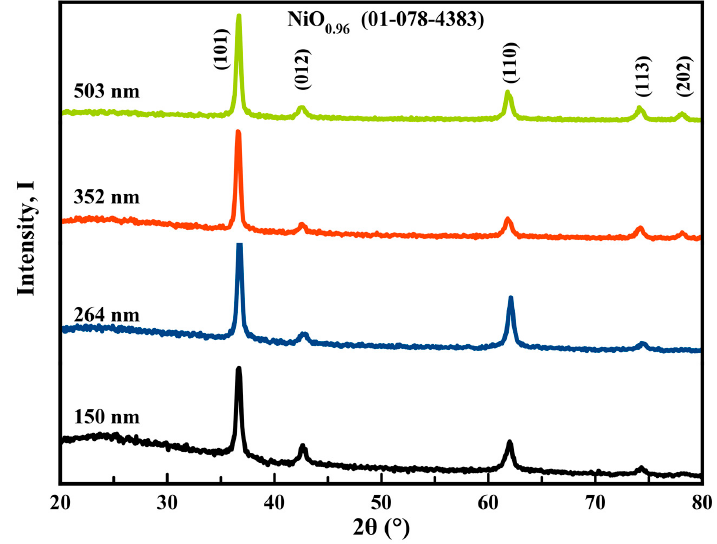
Figure 1. XRD of NiO x thin films at different thicknesses.